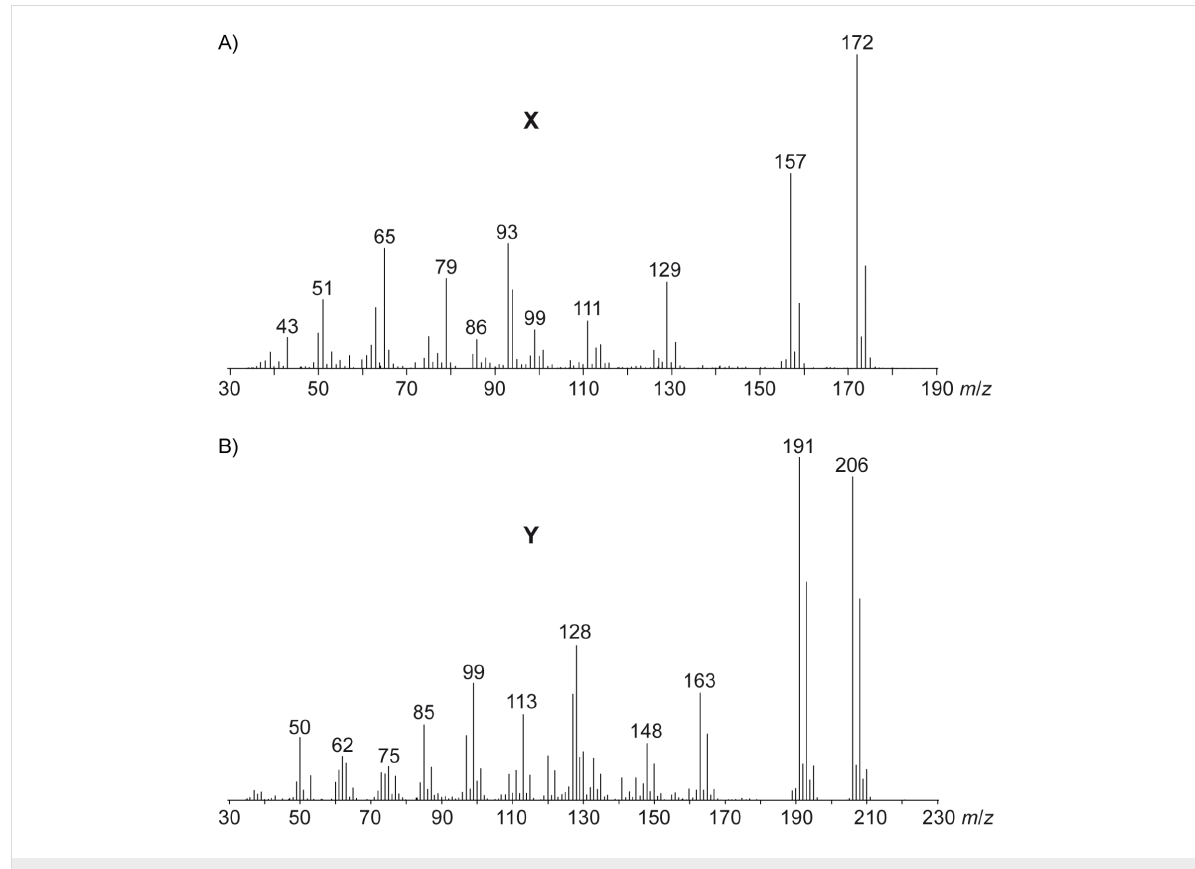
Figure 2: Mass spectra of A) the chlorinated volatile X and B) the chlorinated volatile Y .